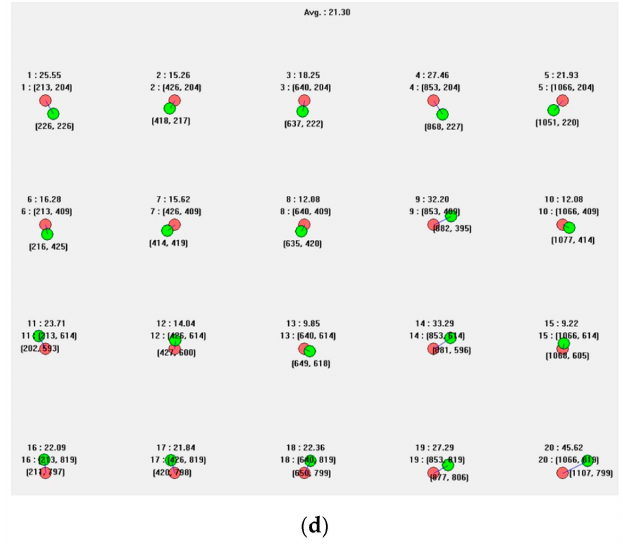
Figure 16. Results of a circular marker type expressed sequentially: ( a ) an inaccurate calibration, ( b ) an error in the gaze tracking accuracy of 1.223 ˝ ; ( c ) an accurate calibration; and ( d ) an error in the gaze tracking accuracy of 0.407 ˝